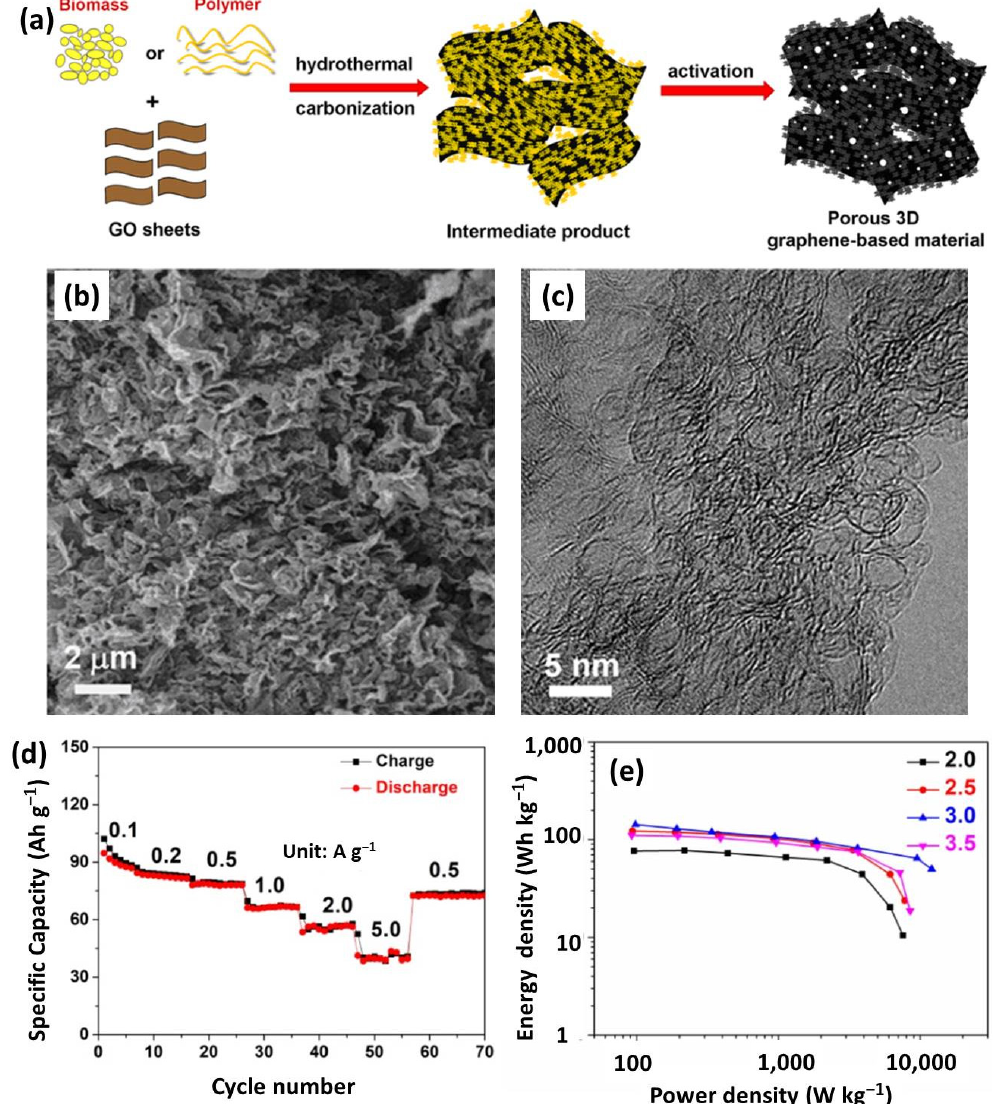
Figure 6. ( a ) A preparation schematic of porous 3D graphene-based materials; ( b ) SEM and ( c ) TEM images of porous 3D graphene-based products. Reproduced with permission from Ref. [13]. Copyright 2013, Springer Nature. ( d ) Rate performance of 3D graphene-based cathode; ( e ) Ragone plots of all-graphene-based LICs with different mass ratios. Reproduced with permission from Ref. [129]. Copyright 2021, IOP Publishing.